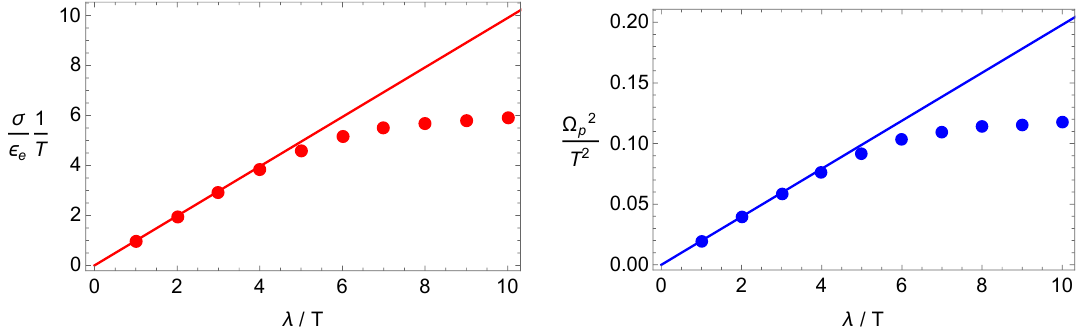
Figure 16 . Plasma frequency Ω p and damping parameter σ/(cid:15) e at finite density ( µ/T = 0 . 5 ) and zero magnetic